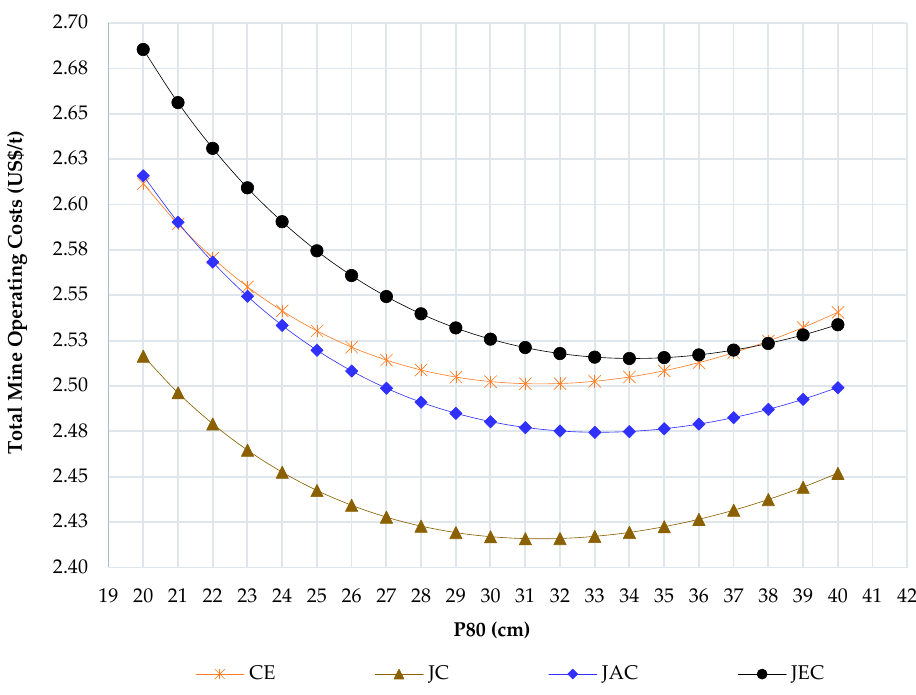
Figure 6. Total mine operating costs as a function of P 80 for CE, JC, JAC and JEC.